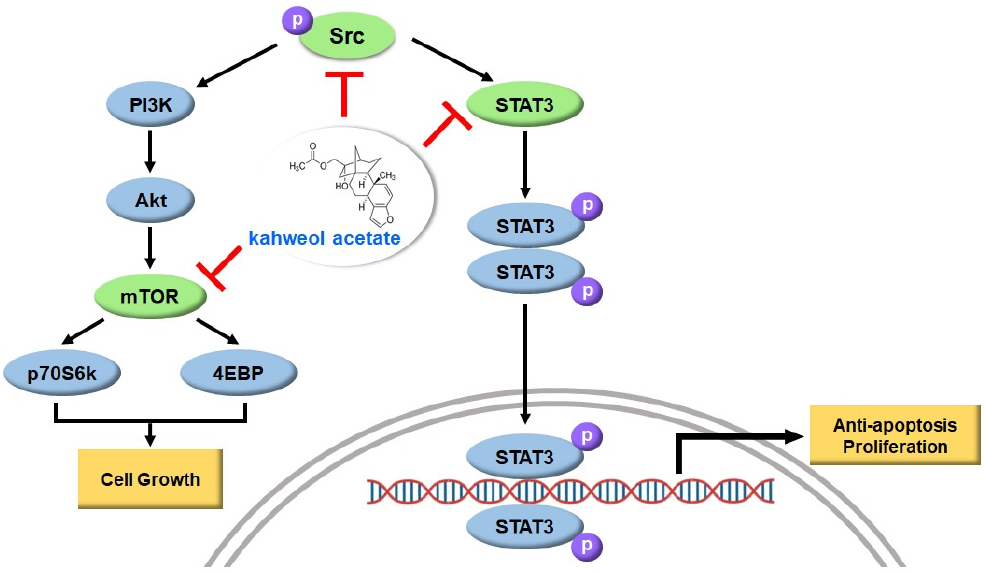
Figure 1. Anti-proliferative and apoptosis properties of kahweol in HCC cells. Kahweol inhibited phosphorylation of Src, mTOR, and STAT3 in HCC cells. Phosphoinositide 3-kinases (PI3K), Mammalian target of rapamycin (mTOR), 70-kDa ribosomal protein S6 kinase (p70S6K), eukaryotic translation initiation factor 4E binding protein (4EBP), Signal transducer and activator of transcription 3 (STAT3).